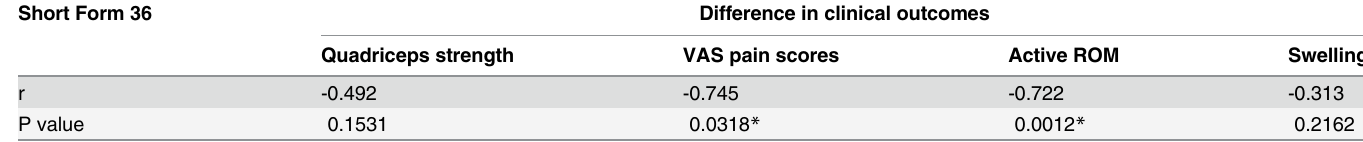
Table 4. Relationship between the magnitude of asymmetry and Short-Form 36 Short Form